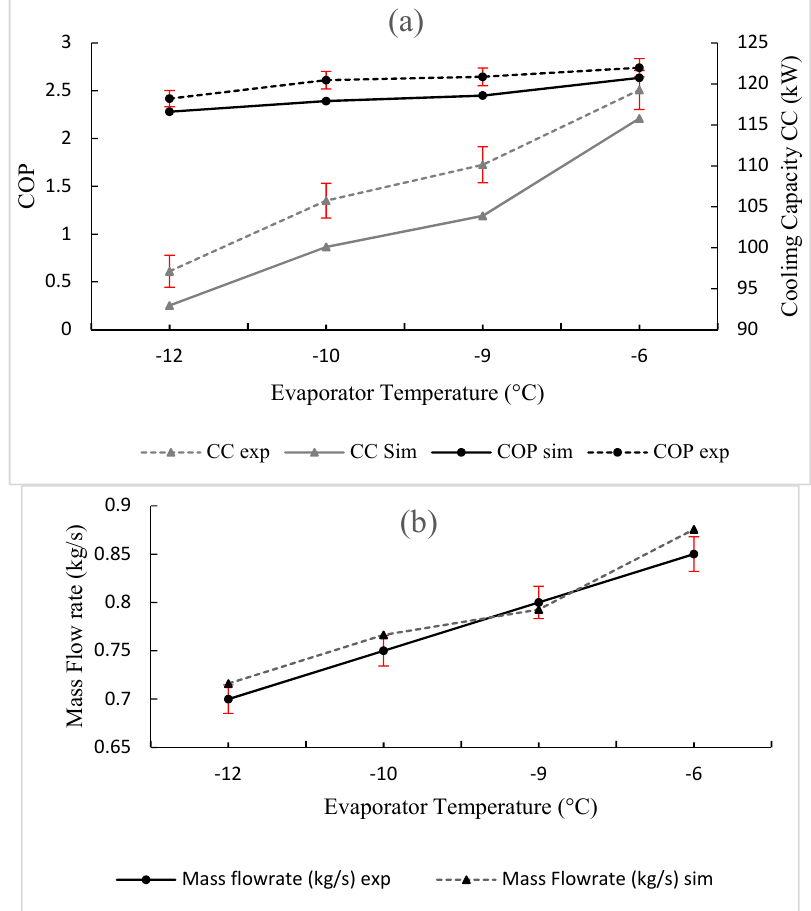
Figure 4. Validation of EES model; ( a ) validation of COP and cooling capacity of R22, ( b ) validation of mass flow rate of R22.